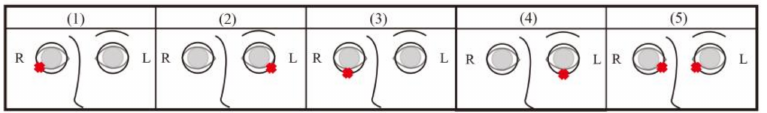
Figure 3. Expected stimulated area on human eyeball surface: ( 1 ) the expected stimulated area is the lower temporal right eyeball surface; ( 2 ) the expected stimulated area is the lower temporal left eyeball surface; ( 3 ) the expected stimulated area is the lower central right eyeball surface; ( 4 ) the expected stimulated area is the lower central left eyeball surface; ( 5 ) the expected stimulated area is the lower nasal both eyeballs’ surfaces; the red cross in each figure represents the expected stimulated